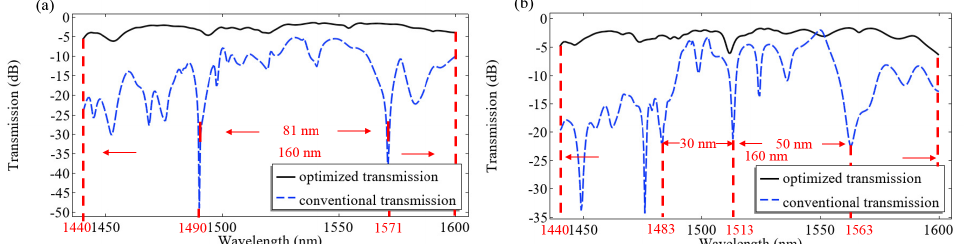
Figure 3. Diagram of transmission spectrum as a function of light wavelength from 1440 nm to 1600 nm. ( a ) Straight Z waveguide; ( b ) curved Z waveguide. The blue dotted line for the un- optimized waveguide bend and the black solid line for the optimized waveguide bend. The red dashed line represents the relatively low transmission-loss part between the two inverted peaks defined. The wavelength of the defined inverted peak position is indicated by red